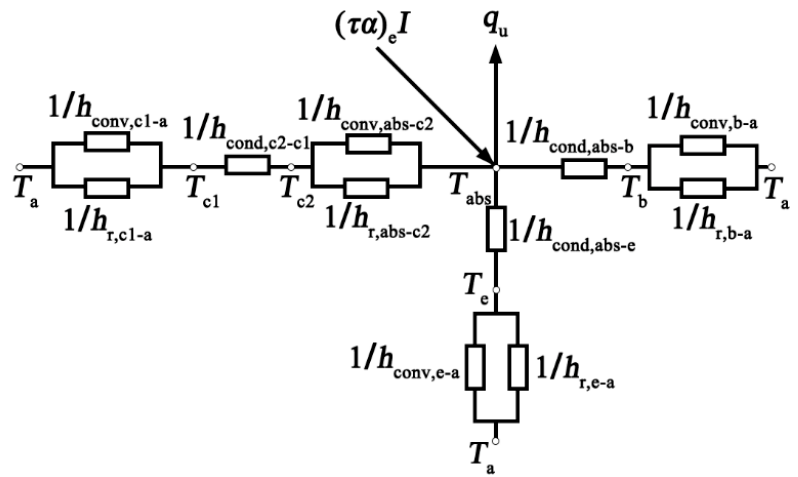
Figure 6. Total heat loss composition of a VTBC solar collector.